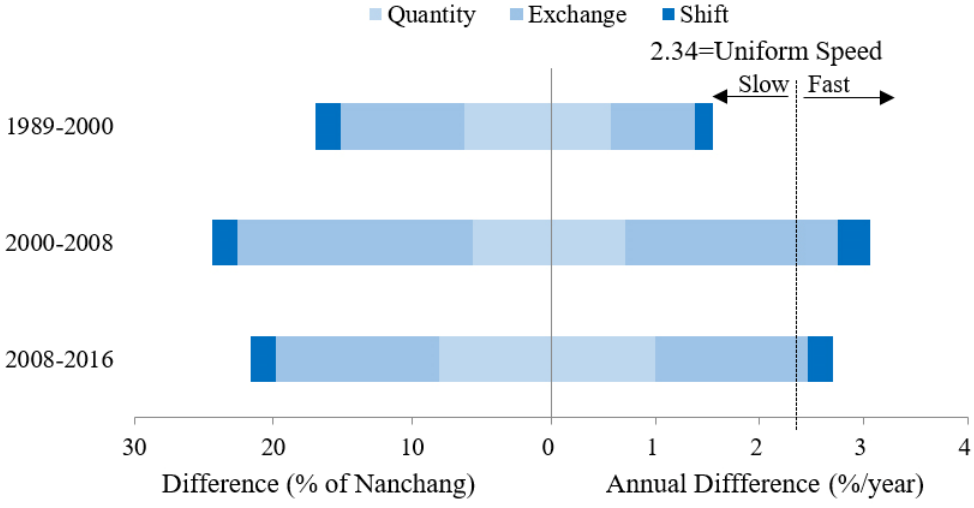
Figure 7. Size of temporal difference on the left and annual difference on the right during three time intervals.